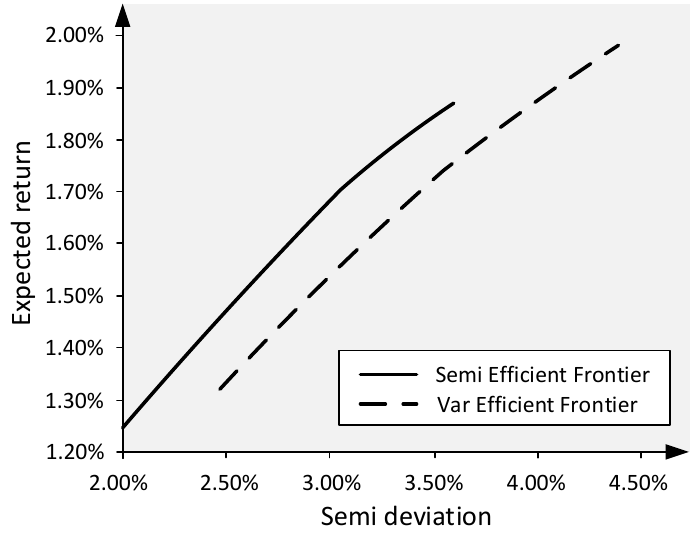
Figure 2. Mean-variance and mean semi-variance efficient frontiers by Boasson et al.